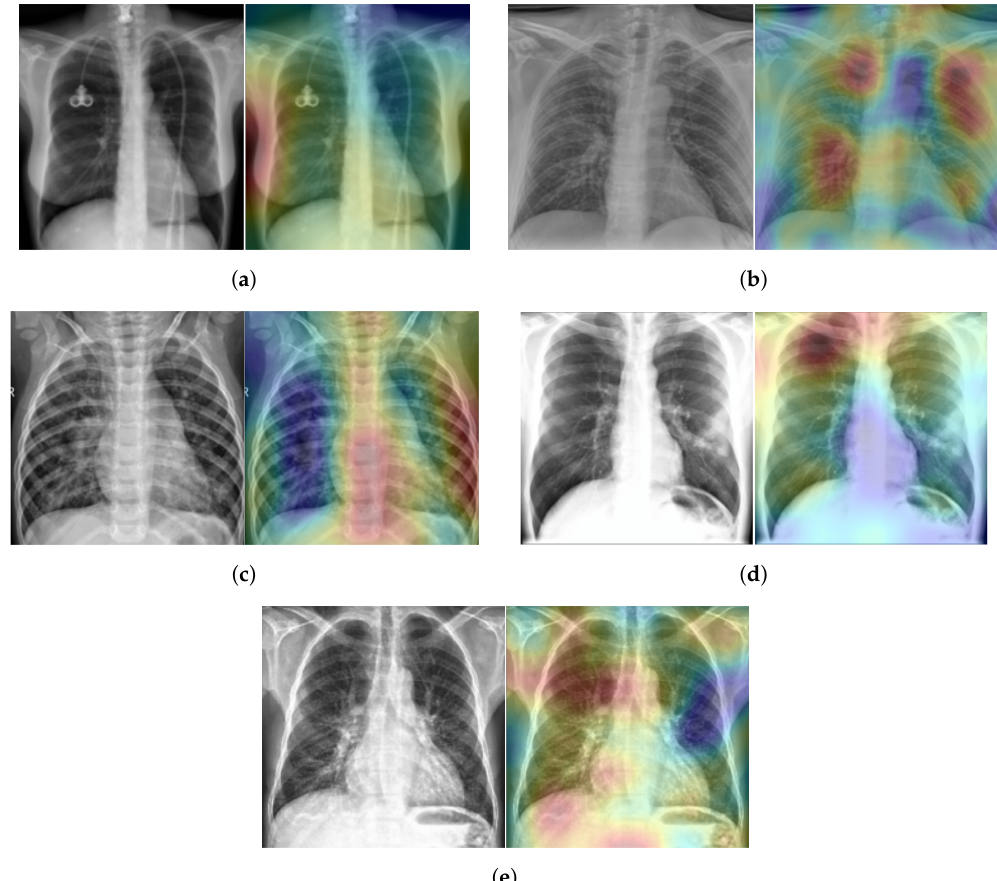
Figure 11. ( a ) Normal case, ( b ) COVID-19 case, ( c ) Viral Pneumonia case, ( d ) Bacterial Pneumonia case, ( e ) Lung Opac- ity